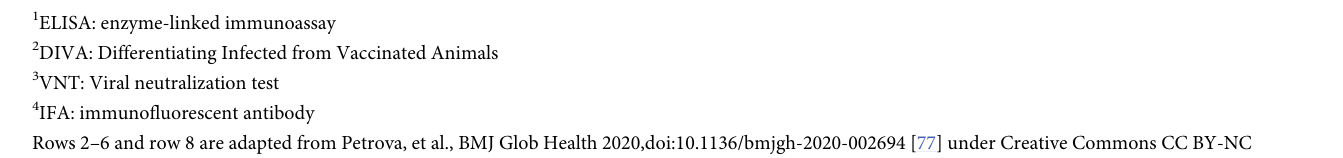
Rows 2–6 and row 8 are adapted from Petrova, et al., BMJ Glob Health 2020,doi:10.1136/bmjgh-2020-002694 [77] under Creative Commons CC